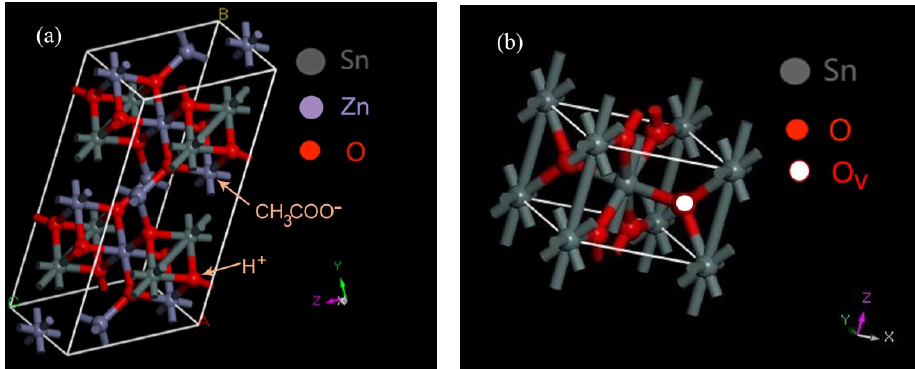
Figure 1. The formation schematic diagram of SnO 2 − x nanocrystals in an acetic acid media under the hydrothermal condition. ( a ) ZSO structure; ( b ) SnO 2 − x structure.